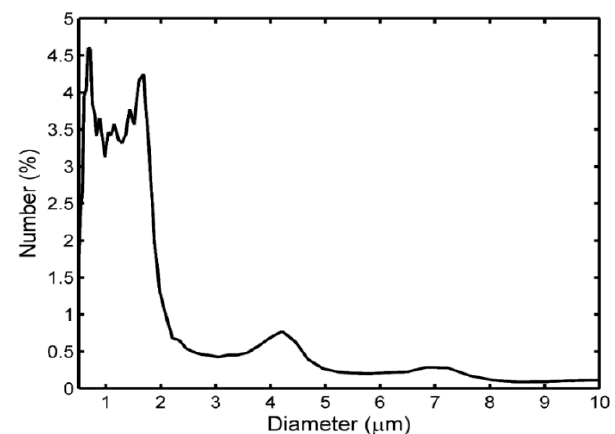
Figure 1. Size distribution of SonoVue microbubbles. 95% of microbubbles were in the diameter range of 0.7–10 μ m and the mean diameter of the range was 2.5 μ m.